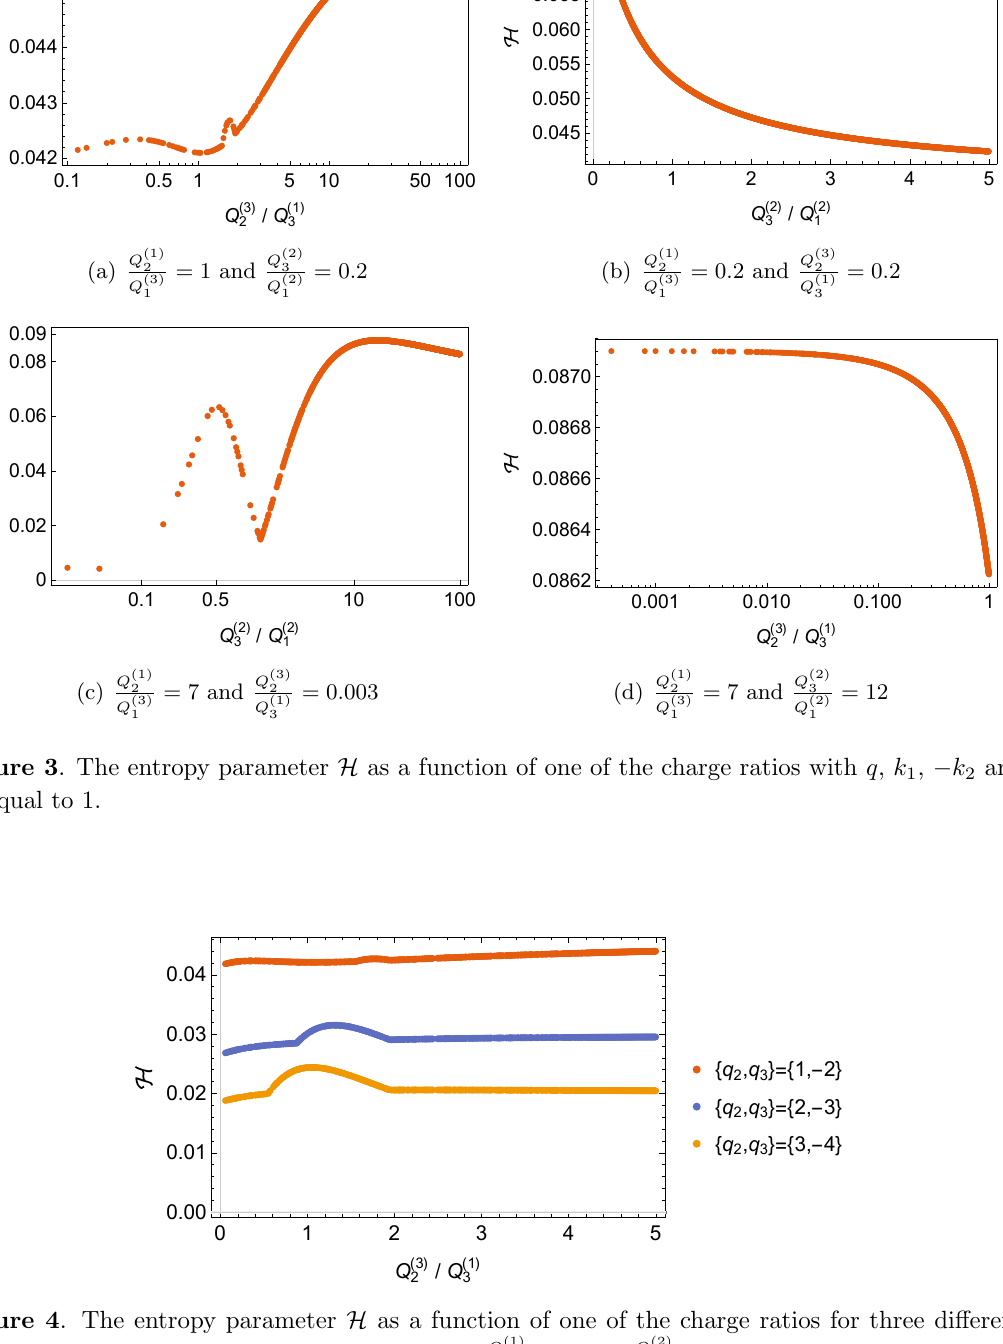
(1) (2) = 1 and Q = 0 : 2 3 Q (3) 1 Q (2) 1